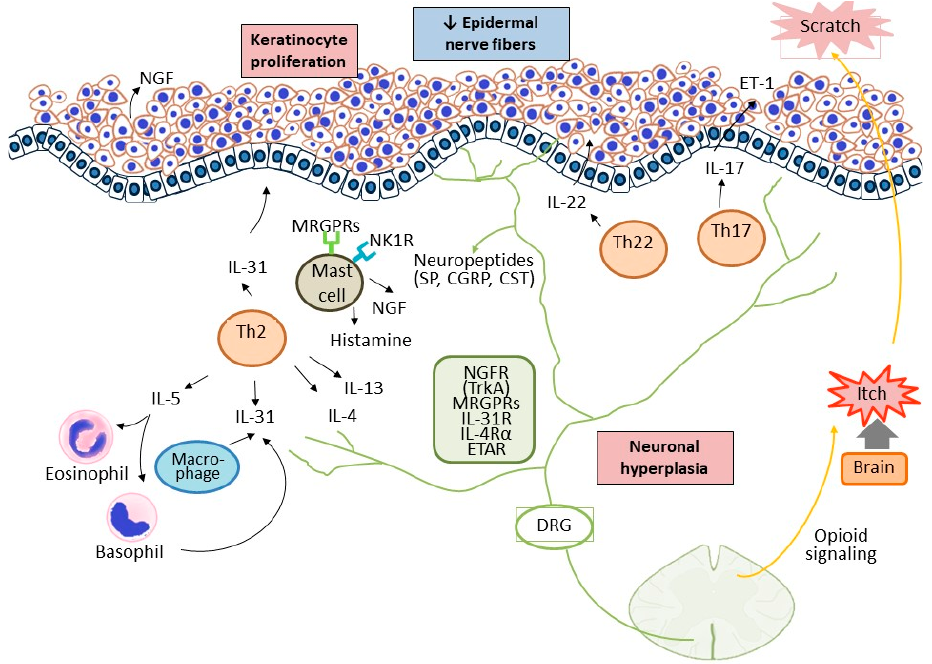
Figure 1. The interplay among the cutaneous, immune, and nervous systems in patients with CNPG. Keratinocyte is a big source of growth factors and inflammatory cytokines, which leads to immune activation. Enhanced infiltration of Th2, Th17/IL-17, Th22/IL-22, eosinophils, and mast cells initiates the inflammatory process and promote keratinocytes hyperproliferation. Simultaneously, neuronal hyperplasia in the dermis further releases neuropeptides, such as substance P, which activate the immune response by interplaying with the immune cells and keratinocytes. The itch-scratch vicious cycle execrates the inflammatory process and scratching causes mechanical damage to peripheral nerve fibers in the epidermis. SP, substance P; NK1R, neurokinin 1 receptor; CST, cortistatin; NGF, nerve growth factor; TrkA, tyrosine kinase receptor A; MRGPRs, Mas-related G-protein-coupled receptors; DRG, dorsal root ganglion.